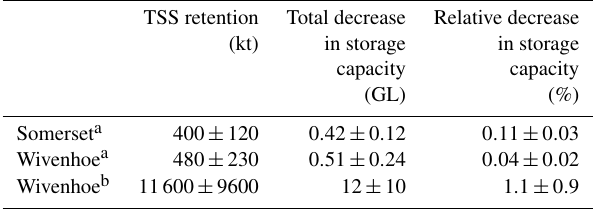
Table 3. TSS retention and estimated decline in storage capacity for Somerset and Wivenhoe reservoirs from June 1997 to July 2011, assuming a sediment bulk density of 0.95gcm − 3